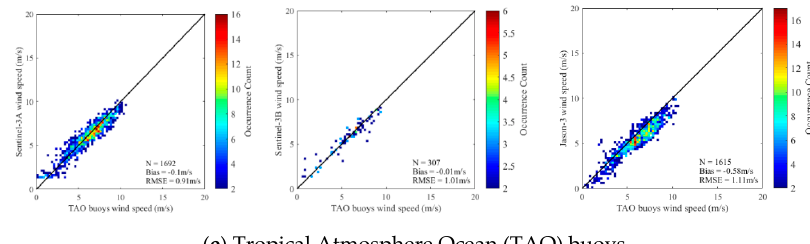
Figure 3. Comparisons of wind speed (WS) between Sentinel-3A, Sentinel-3B, and Jason-3 altimeters and moored buoys. ( a ) all buoys; ( b ) NDBC buoys; ( c ) PIRATA buoys; ( d ) RAMA buoys; ( e ) TAO buoys.